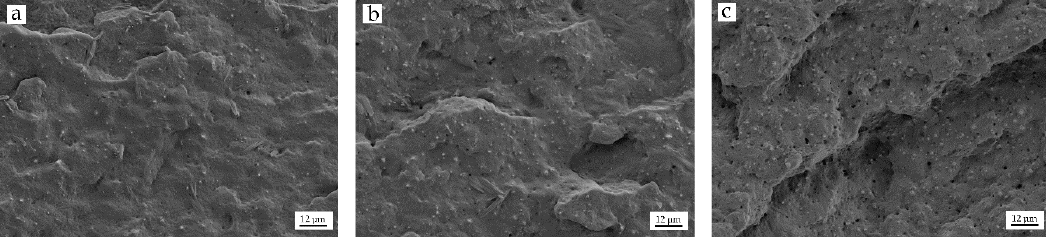
Figure 2. Field emission scanning electron microscopy (FESEM) images at 5000 × of the fracture surfaces of PA610 / HNT composites: ( a ) PA610 / 10HNTs; ( b ) PA610 / 20HNTs and ( c ) PA610 / 30HNTs.